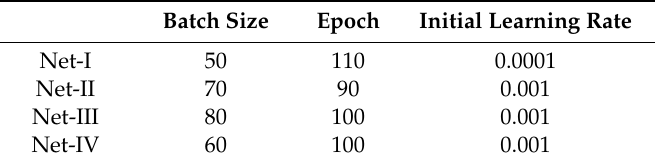
Table 10. Optimal hyperparameters obtained by Bayesian optimization. Batch Size Epoch